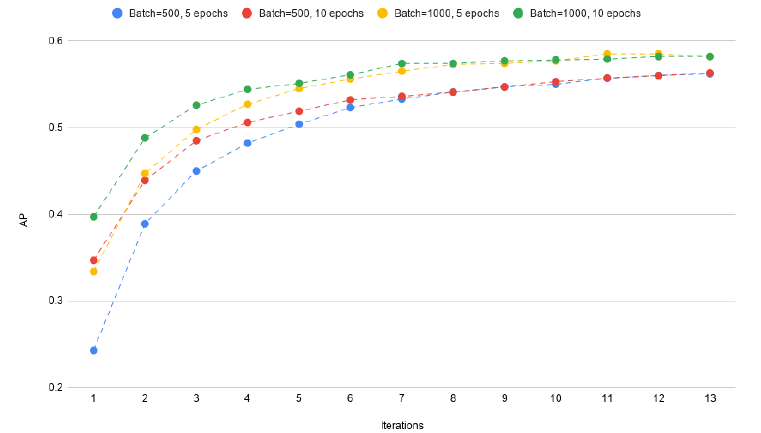
Figure 3. AP to the number of iterations for network trained with batch size of 500 and 1000.